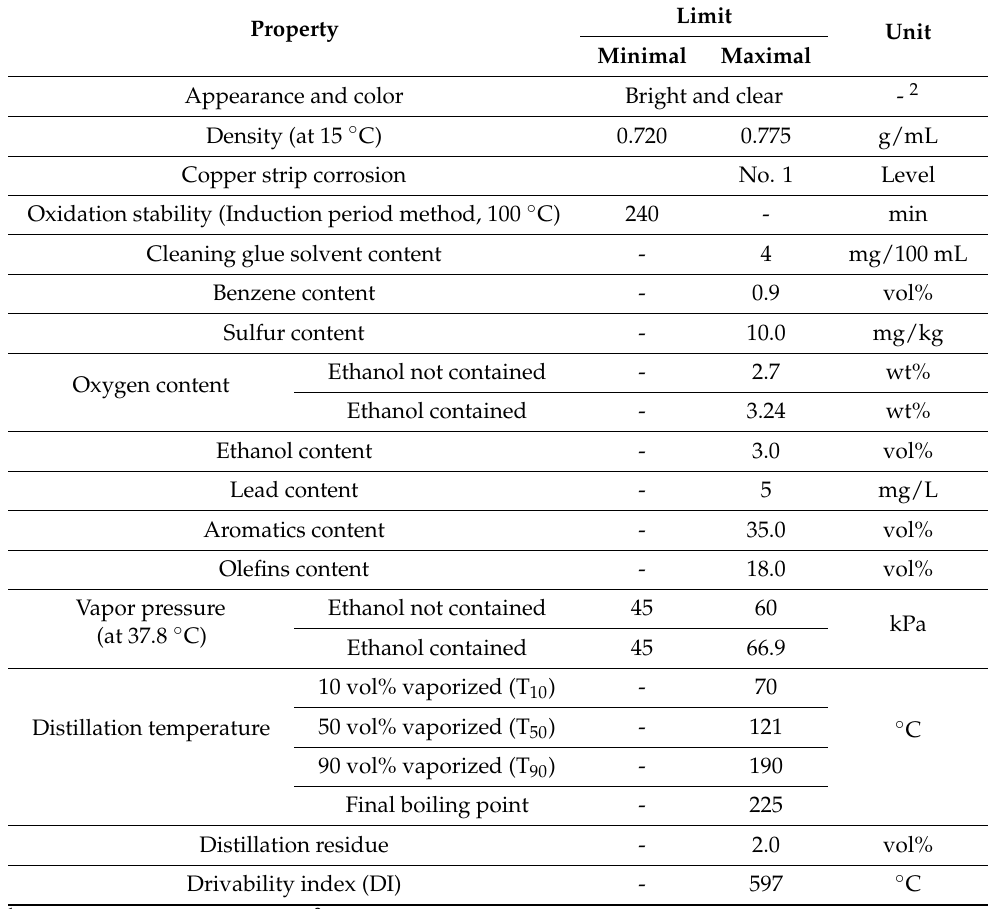
Table 2. Specifications of unleaded gasoline for automobiles in Taiwan 1 .